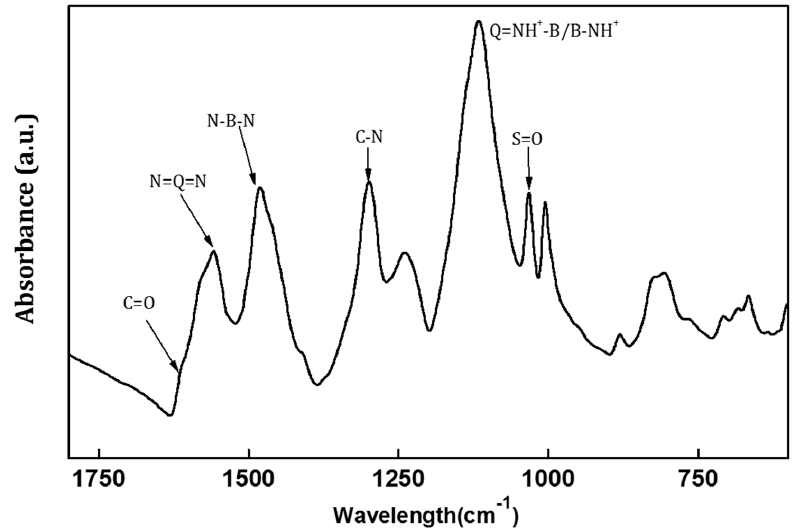
Figure 1. FTIR spectra of the PANI/EG composite membrane.